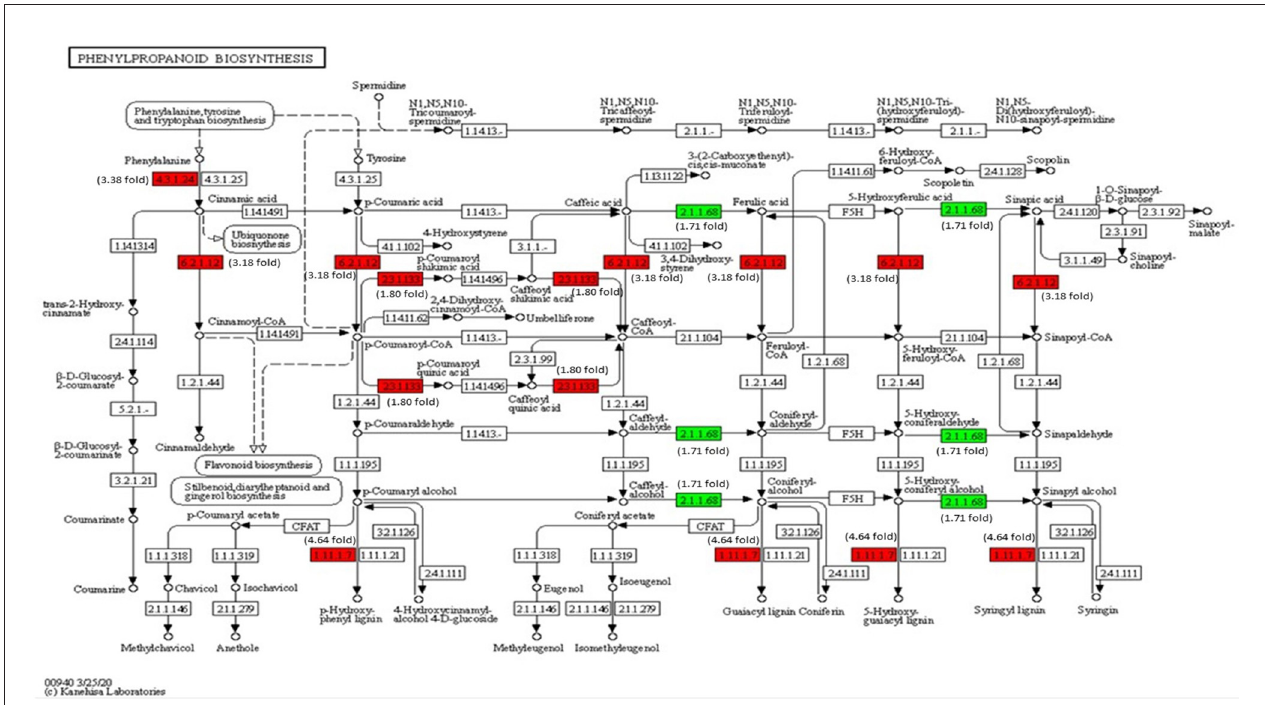
FIGURE 9 | Modulation of gene expression in phenylpropanoid biosynthesis in tomato plant by Cg-2 treatment. (Red color represents upregulated genes, and green color represents downregulated genes).